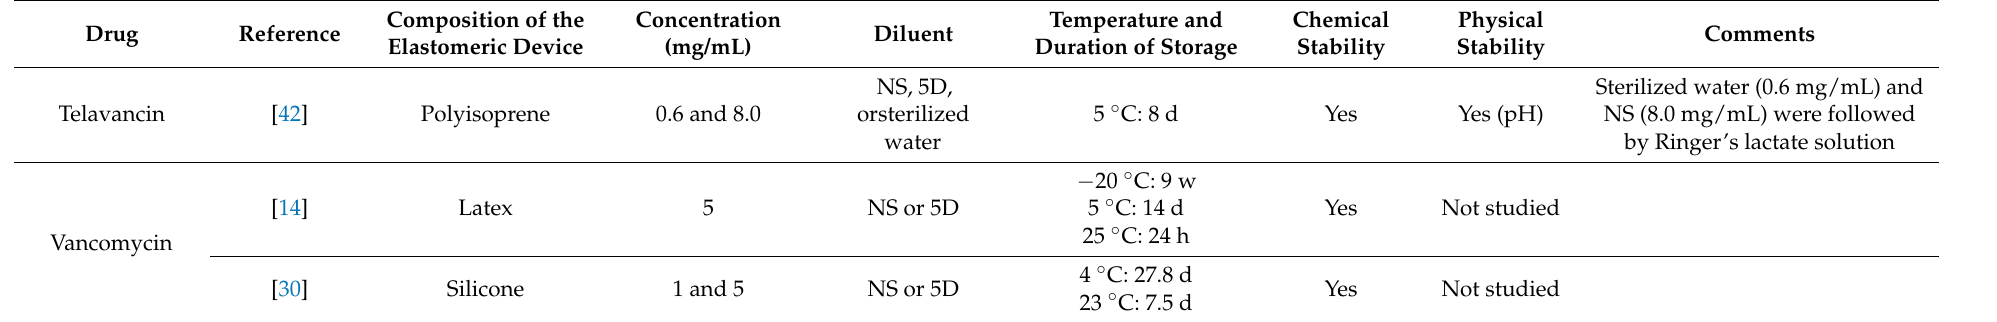
Table 5. Stability of glycopeptides in elastomeric